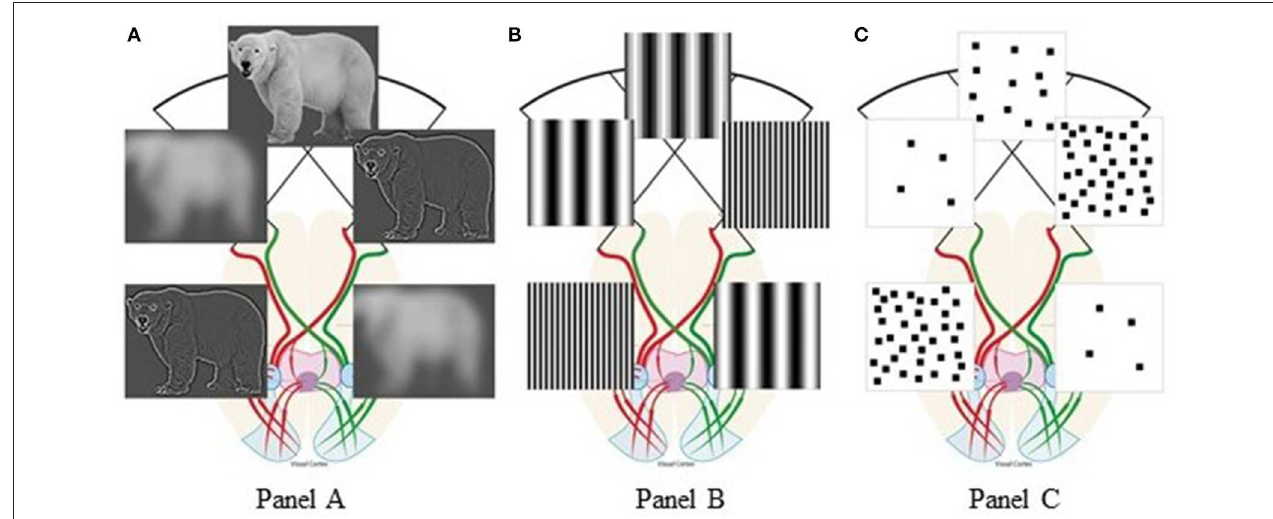
FIGURE 1 | Visual percepts resulting from hemispheric spatial frequency tuning: (A) polar bear scenes, adapted from “Figure 3” Panichello et al. (2013), licensed under CC-BY, version 4.0; (B) spatial frequency gratings; (C) square-pattern stimuli taken from the target article by Di Giorgio et al. (2019). The anatomy of visual pathways is redrawn after “Figure 1. Visual pathway in a primate.” by Larsson (2015), used under CC-BY, version 4.0. Figure 1 is licensed under CC-BY, version 4.0 by Arianna